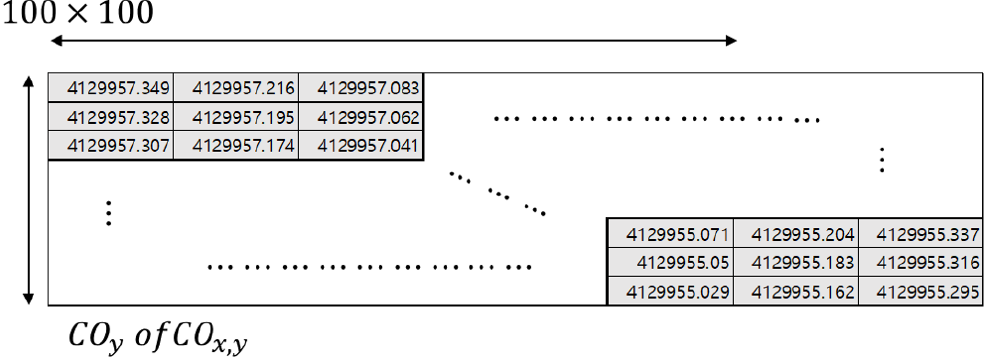
Figure 18. The 100 by 100 matrix about the x-axis value, which comes from the computation of CO x , y .